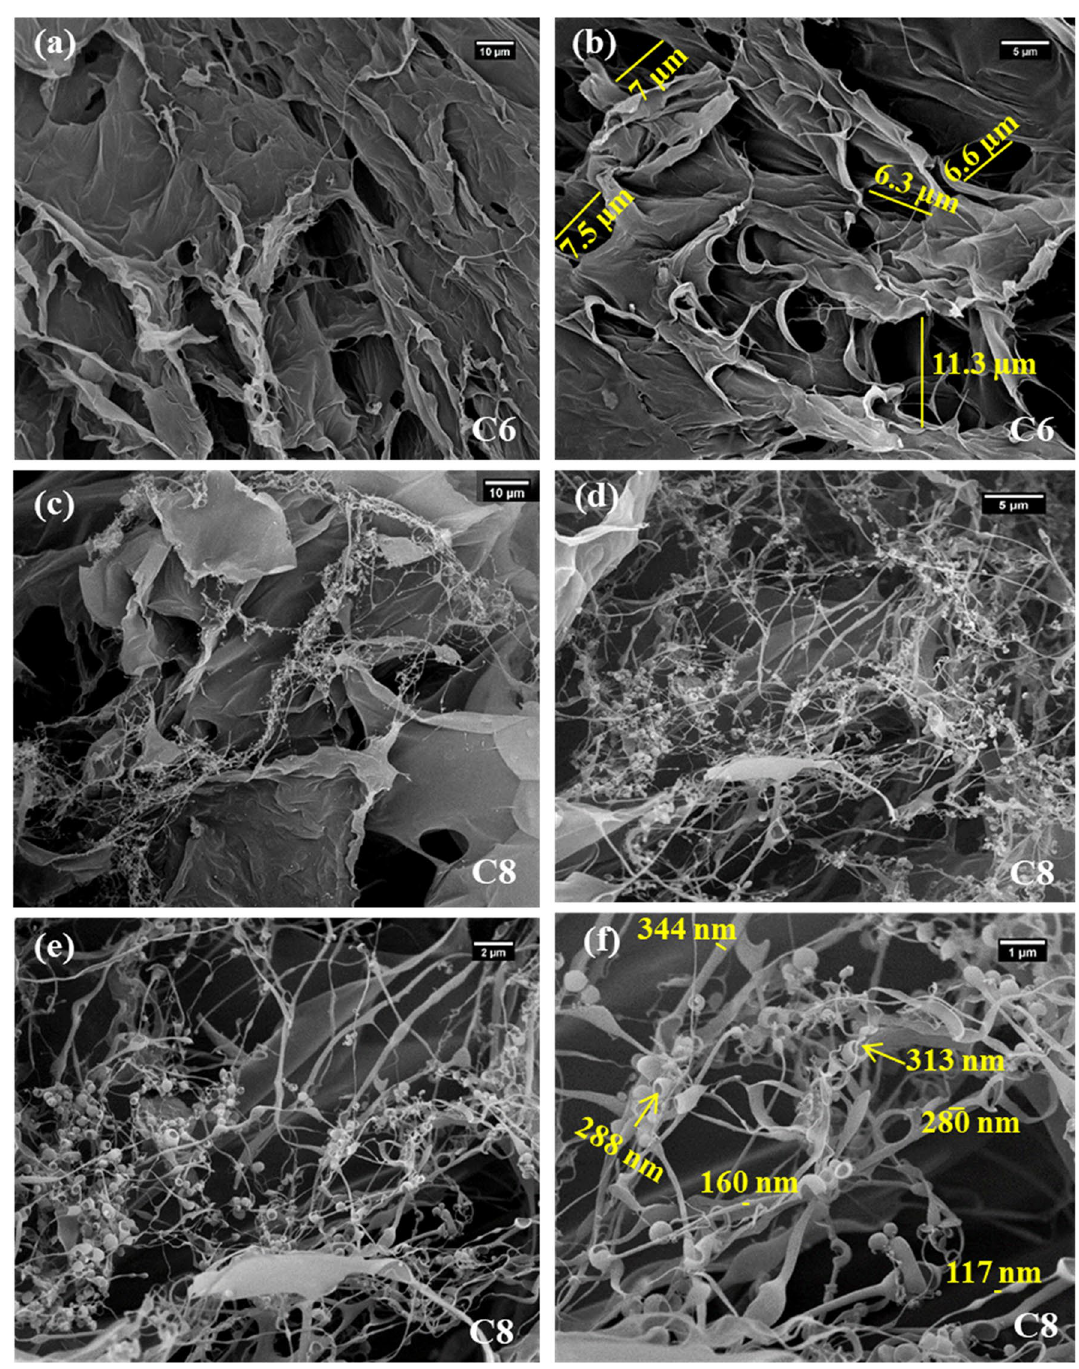
Figure 4. SEM images of selected CH-based hydrogels ( a , b ) C6, and ( c – f ) C8